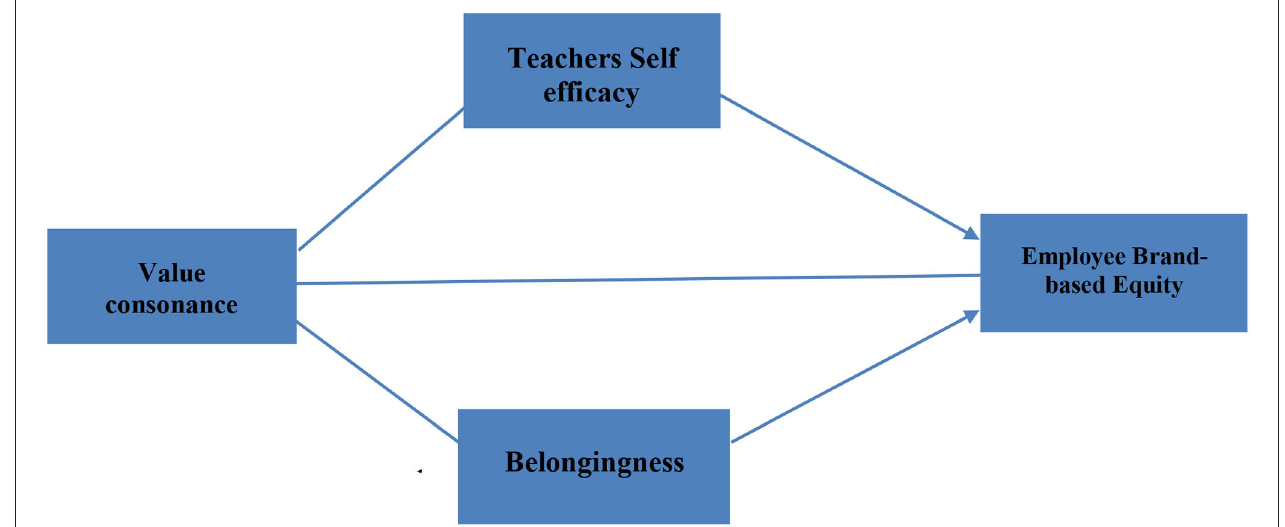
FIGURE 1 | Conceptual